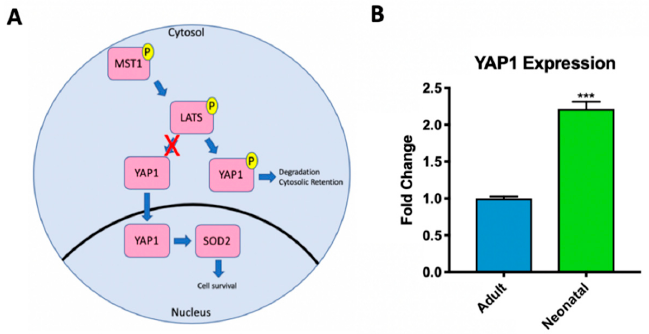
Figure 2. The Hippo signaling pathway phosphorylates and inactivates YAP1 when the pathway is active ( A ). Adults have limited expression of active YAP1 compared to neonates ( B ). *** p < 0.001. Fold changes are shown as the mean ± SEM. All samples were run in triplicate.